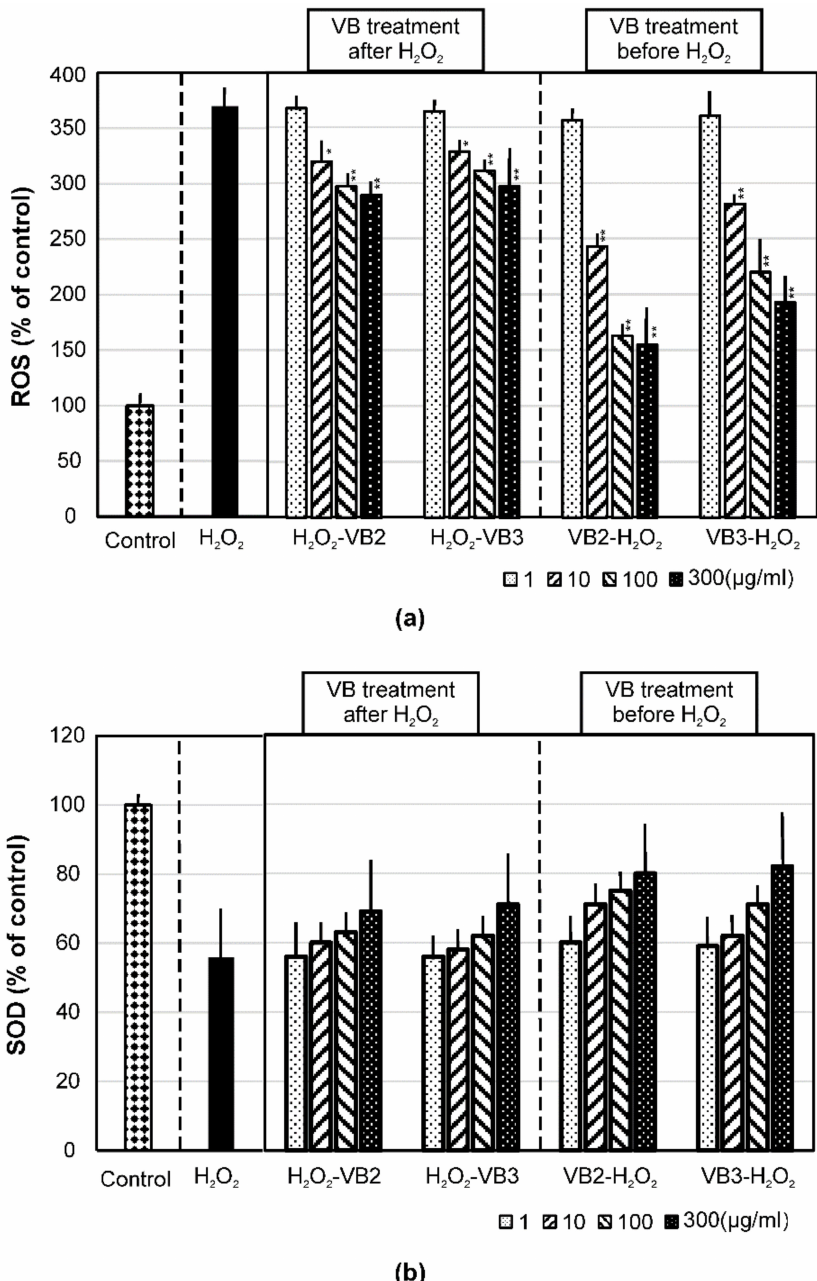
Figure 5. Effects of VBs on the generation of ROS and SOD in NHDF treated with H 2 O 2 . To evaluate the therapeutic effects of VBs on oxidative stress, NHDF were treated with 0.2 mM H 2 O 2 for 2 h, washed with PBS, and continued to be cultured with VBs for 4 h. In another experiment, cells were initially treated with VBs for 4 h, washed, and then cultured with 0.2 mM H 2 O 2 for 2 h to monitor prophylactic effects. The level of ROS generated in cells was measured using DCF-DA as described in the Materials and Methods ( a ). In addition, the level of intracellular SOD was quantitated and expressed as a percentage of that in the control ( b ). * p < 0.01, ** p <